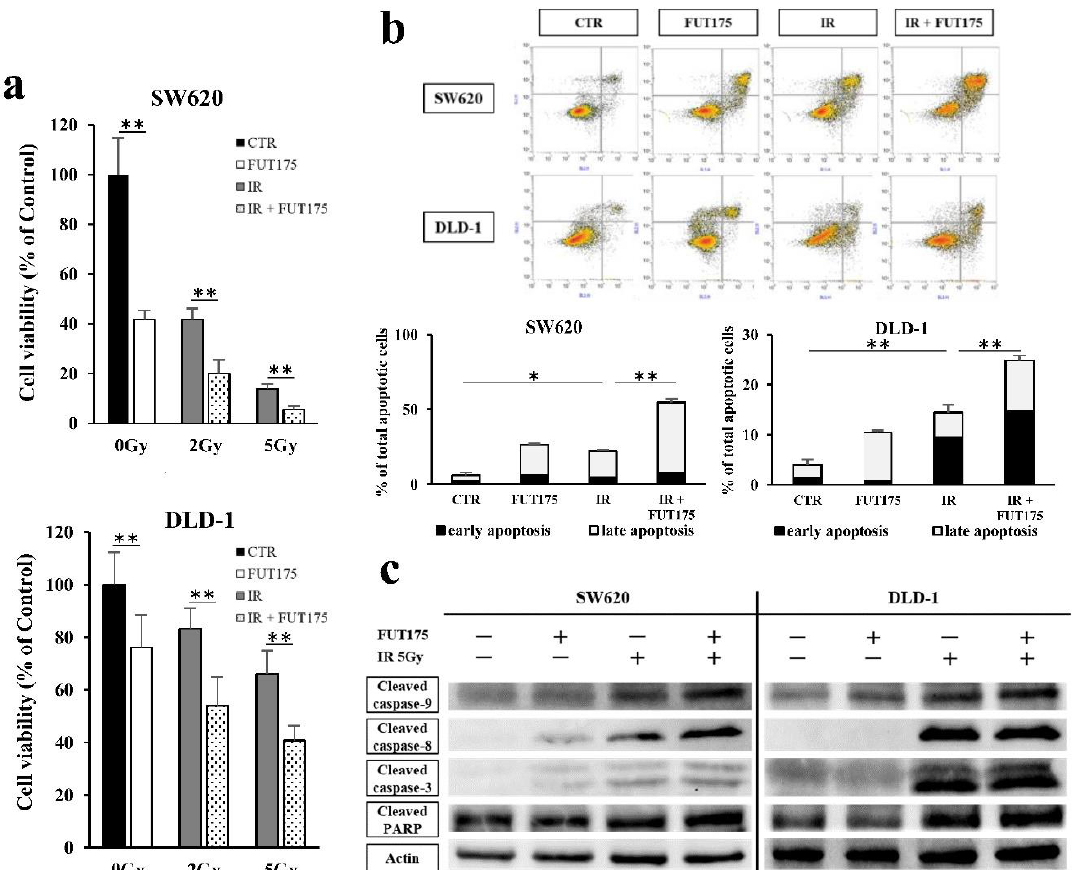
Figure 2. Nafamostat mesilate (FUT175) enhances radiosensitivity and ionizing radiation (IR)-induced cell apoptosis in colorectal cancer (CRC) cells. ( a ) The cells were treated with FUT175 (80 µ g/mL) for 3 h prior to irradiation (2 Gy, 5 Gy). At 96 h of incubation after the treatment, the cell viability was measured. The viability of SW620 and DLD-1 cells in the FUT175 groups was significantly lower than that of cells in the control groups (SW620: 41.6% ± 3.8, p < 0.01; DLD-1: 76.1% ± 12.5, p < 0.01). In the IR groups, cell viability was reduced in a dose-dependent manner. Cell viability in the combination groups was significantly lower than that in the IR groups at each IR dose (SW620, 2 Gy: 20.0% ± 5.5 vs. 41.7% ± 4.5 and 5 Gy: 5.6% ± 1.5 vs. 13.8% ± 1.9, p < 0.01; DLD-1, 2 Gy: 54.0% ± 10.8 vs. 83.2% ± 7.8 and 5 Gy: 40.8% ± 5.6 vs. 66.1% ± 8.9, p < 0.01). ( b ) The cells were treated with FUT175 (80 µ g/mL) for 3 h prior to irradiation (5 Gy). At 72 h of incubation after the treatment, the apoptotic cells were measured by flow cytometry analysis after Annexin/FITC staining. The percentage of early and late apoptotic cells in the combination groups was significantly greater than that in the IR groups (early apoptosis: SW620, 7.5% ± 0.4 vs. 4.5% ± 0.0 and DLD-1, 14.7% ± 0.7 vs. 9.5% ± 1.2, p < 0.01; late apoptosis: SW620, 47.2% ± 2.2 vs. 17.5% ± 0.9 and DLD-1, 10.1% ± 0.4 vs. 4.9% ± 0.5, p < 0.01). ( c ) The cells were treated with FUT175 (80 µ g/mL) for 3 h prior to irradiation (5 Gy). At 24 h of incubation after the treatment, the apoptosis-related proteins were measured by western blot analysis. The levels of cleaved caspase-9/-8/-3, and cleaved PARP in the combination groups were greater than those in the other groups. *, p < 0.05; **, p < 0.01. All experiments were performed in triplicate.